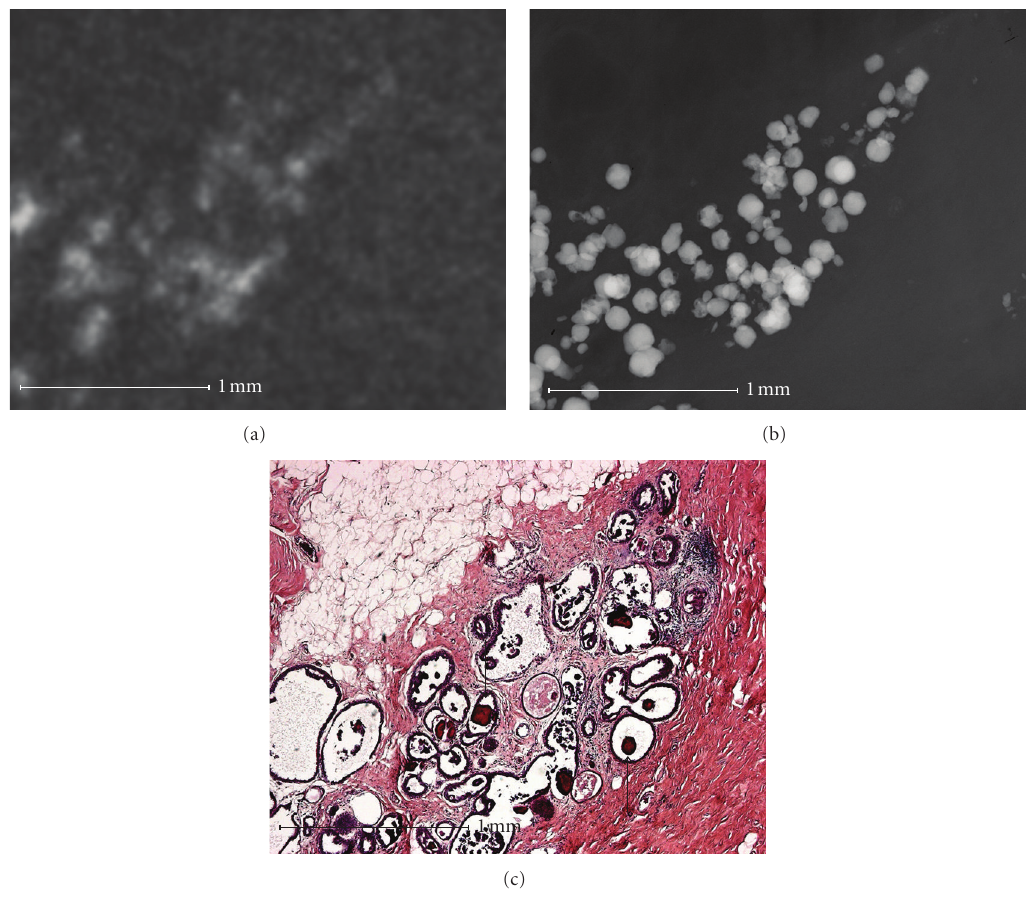
Figure 3: Fibrocystic mastopathy with sclerosing adenosis. Round microcalcification that is typically benign in microradiography (b) appears linear and amorphous in conventional specimen radiography as a result of the superposition (a). The calcification is marked by arrows in the histological picture